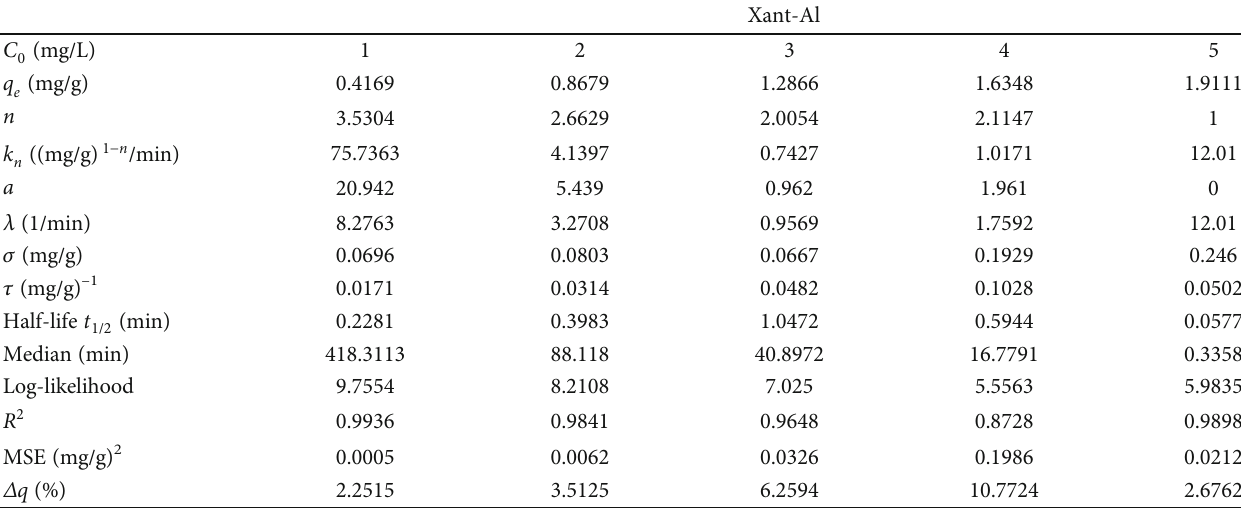
Table 3: Estimated parameter values of the TOU model and goodness-of- fi t measures for the adsorption kinetics of fl uoride by Xant-Al at initial fl uoride concentrations of 1, 2, 3, 4, and 5mg/L.